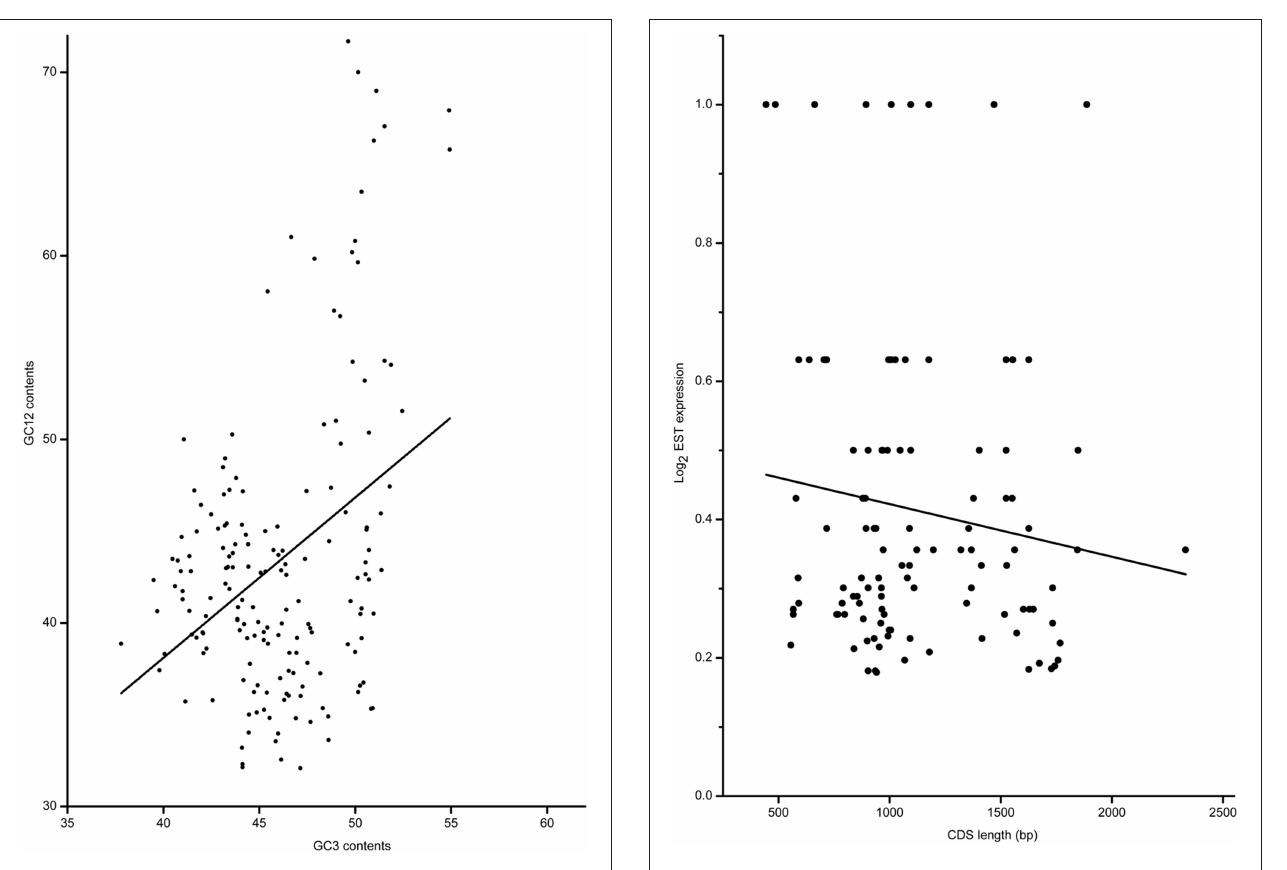
FIGURE 2 | Neutrality plots (GC12 vs. GC3s). The regression line: y = 0.87345X + 3.15405.